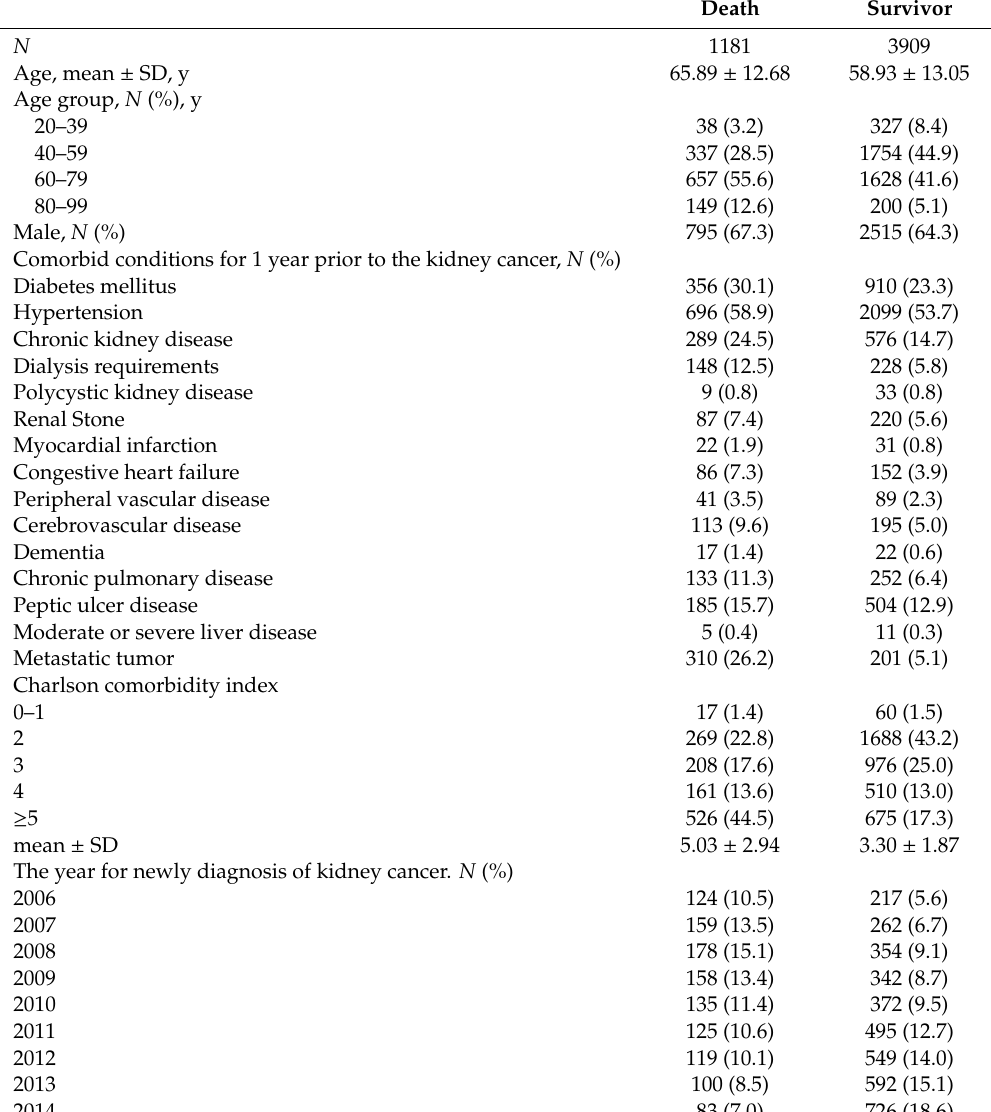
Table 1. Demographic and clinical characteristics of patients with kidney cancer from National health Insurance Research Database (Taiwan).